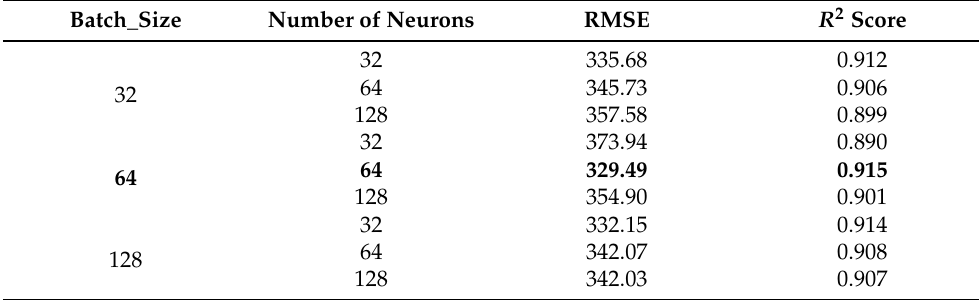
Table 2. Experimental results (time_step = 10).